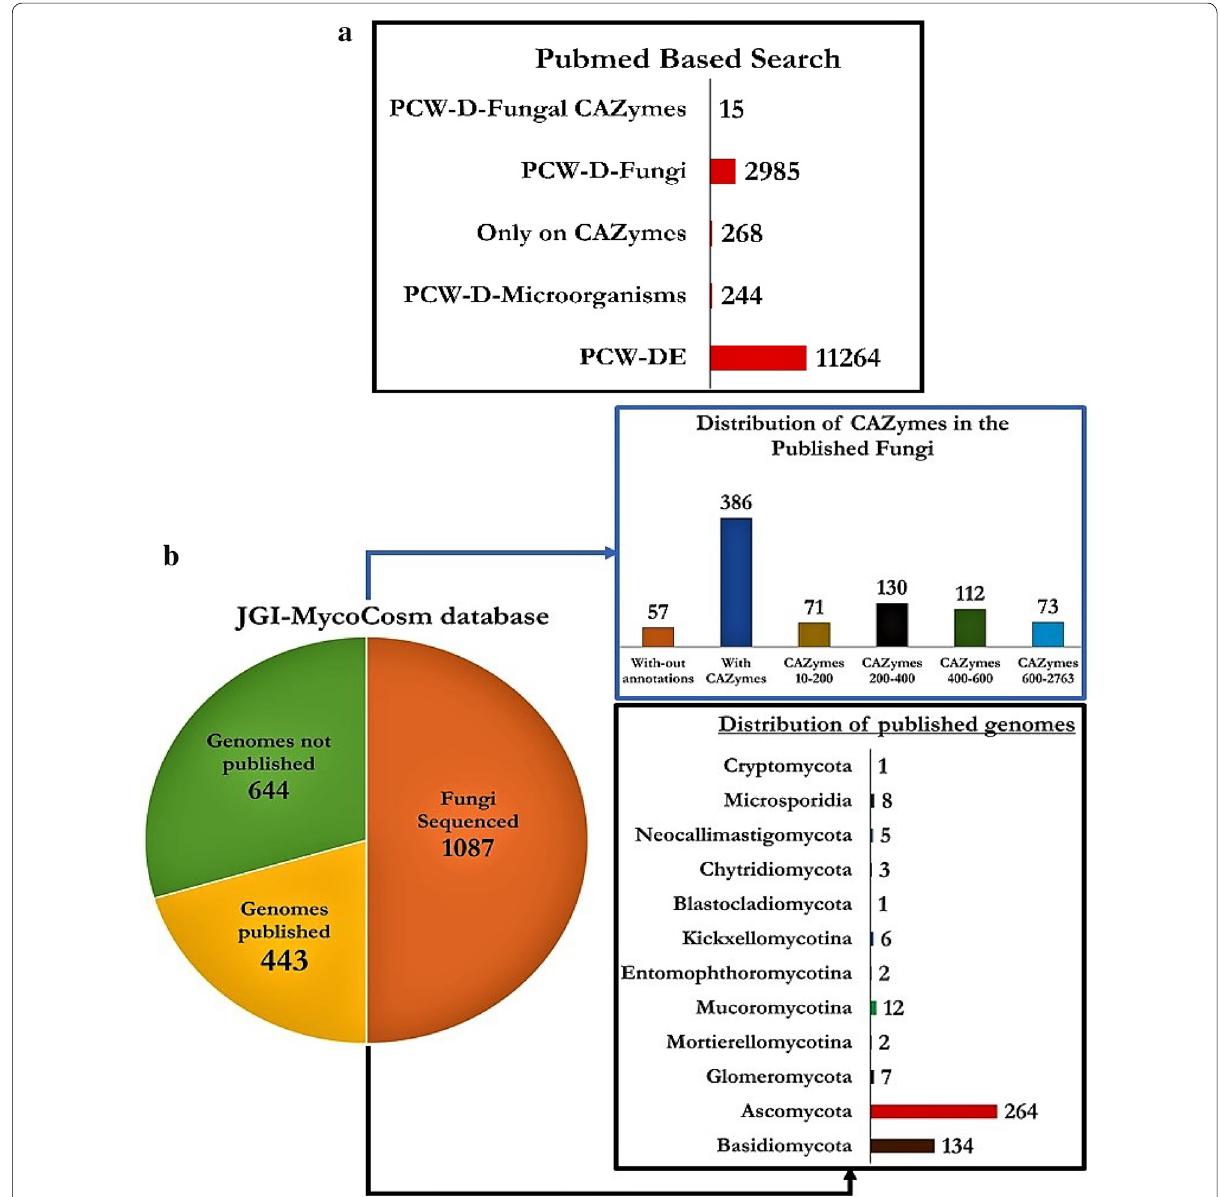
Fig. 3 Pictorial representation of fungal genomes: a PubMed-based search using plant cell wall degradation; b distribution of fungal genomes in JGI-MycoCosm database. It also displays the distribution of published genomes and distribution of fungal genomes based on CAZy